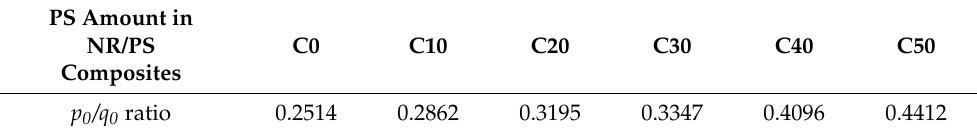
Table 3. Compositional characteristics and p 0 /q 0 ratio for NR/PS